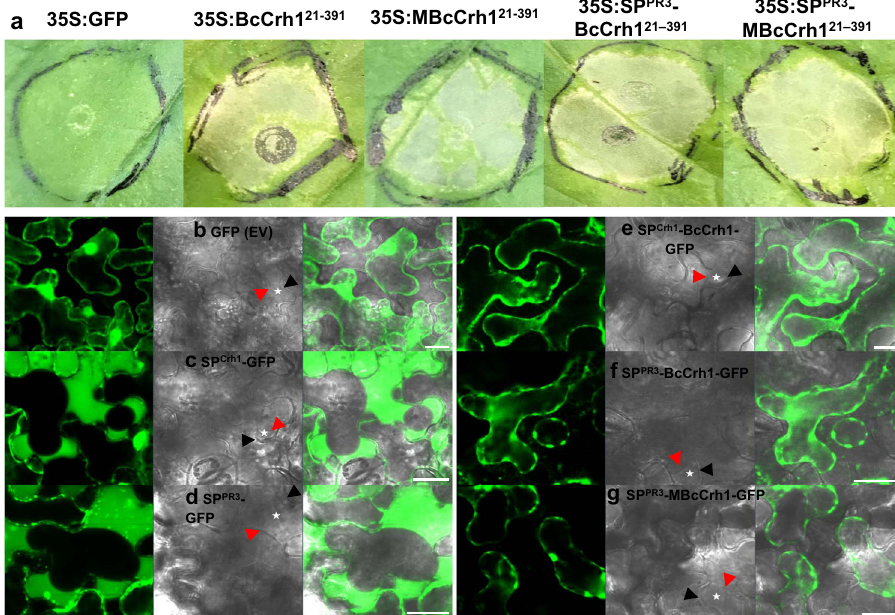
Fig. 1 Localization of BcCrh1 inside plant cells is required for induction of cell death. a Plants were in fi ltrated with Agrobacterium strains that were transformed with the bccrh1 gene with or without secretion signal (SP). Images of necrotic lesions ( a ) were taken fi ve days after Agroin fi ltration. 35S:GFP: free GFP (control); 35S:BcCrh1 -SP and 35S:MBcCrh1 -SP : native and enzyme inactive BcCrh1 respectively, without secretion signal; 35S:SP PR3 -BcCrh1 21 – 391 and 35S:SP PR3 -MBcCrh1 21 – 391 : fusion of the native and enzyme inactive BcCrh1 respectively, with PR3 plant signal peptide; b – g Subcellular localization of GFP-fusion proteins. Leaves were harvested two days after Agroin fi ltration, submerged for 20 min in 0.8 M mannitol to induce plasmolysis, and then samples were scanned by a confocal microscope. White asterisks mark apoplastic space between the cell wall (black arrow) and plasma membrane (red arrow) in plasmolysed plant cells. Left panel shows images of cells following Agroin fi ltration with free GFP (control), right panel shows images following Agroin fi ltration with BcCrh1-GFP fusion protein. b GFP without SP; c GFP fused to the BcCrh1 SP; d GFP fused to PR3 SP; e BcCrh1-GFP with native SP; f BcCrh1-GFP fused to PR3 SP; g MBcCrh1-GFP fused to PR3 SP. Bars = 20 μ m. All the above experiments were repeated at least three times with similar